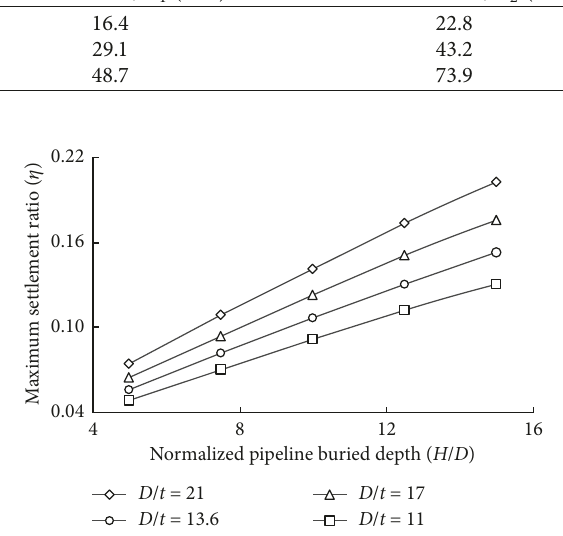
Figure 6: Influence of pipeline buried depth on the maximum settlement ratio.